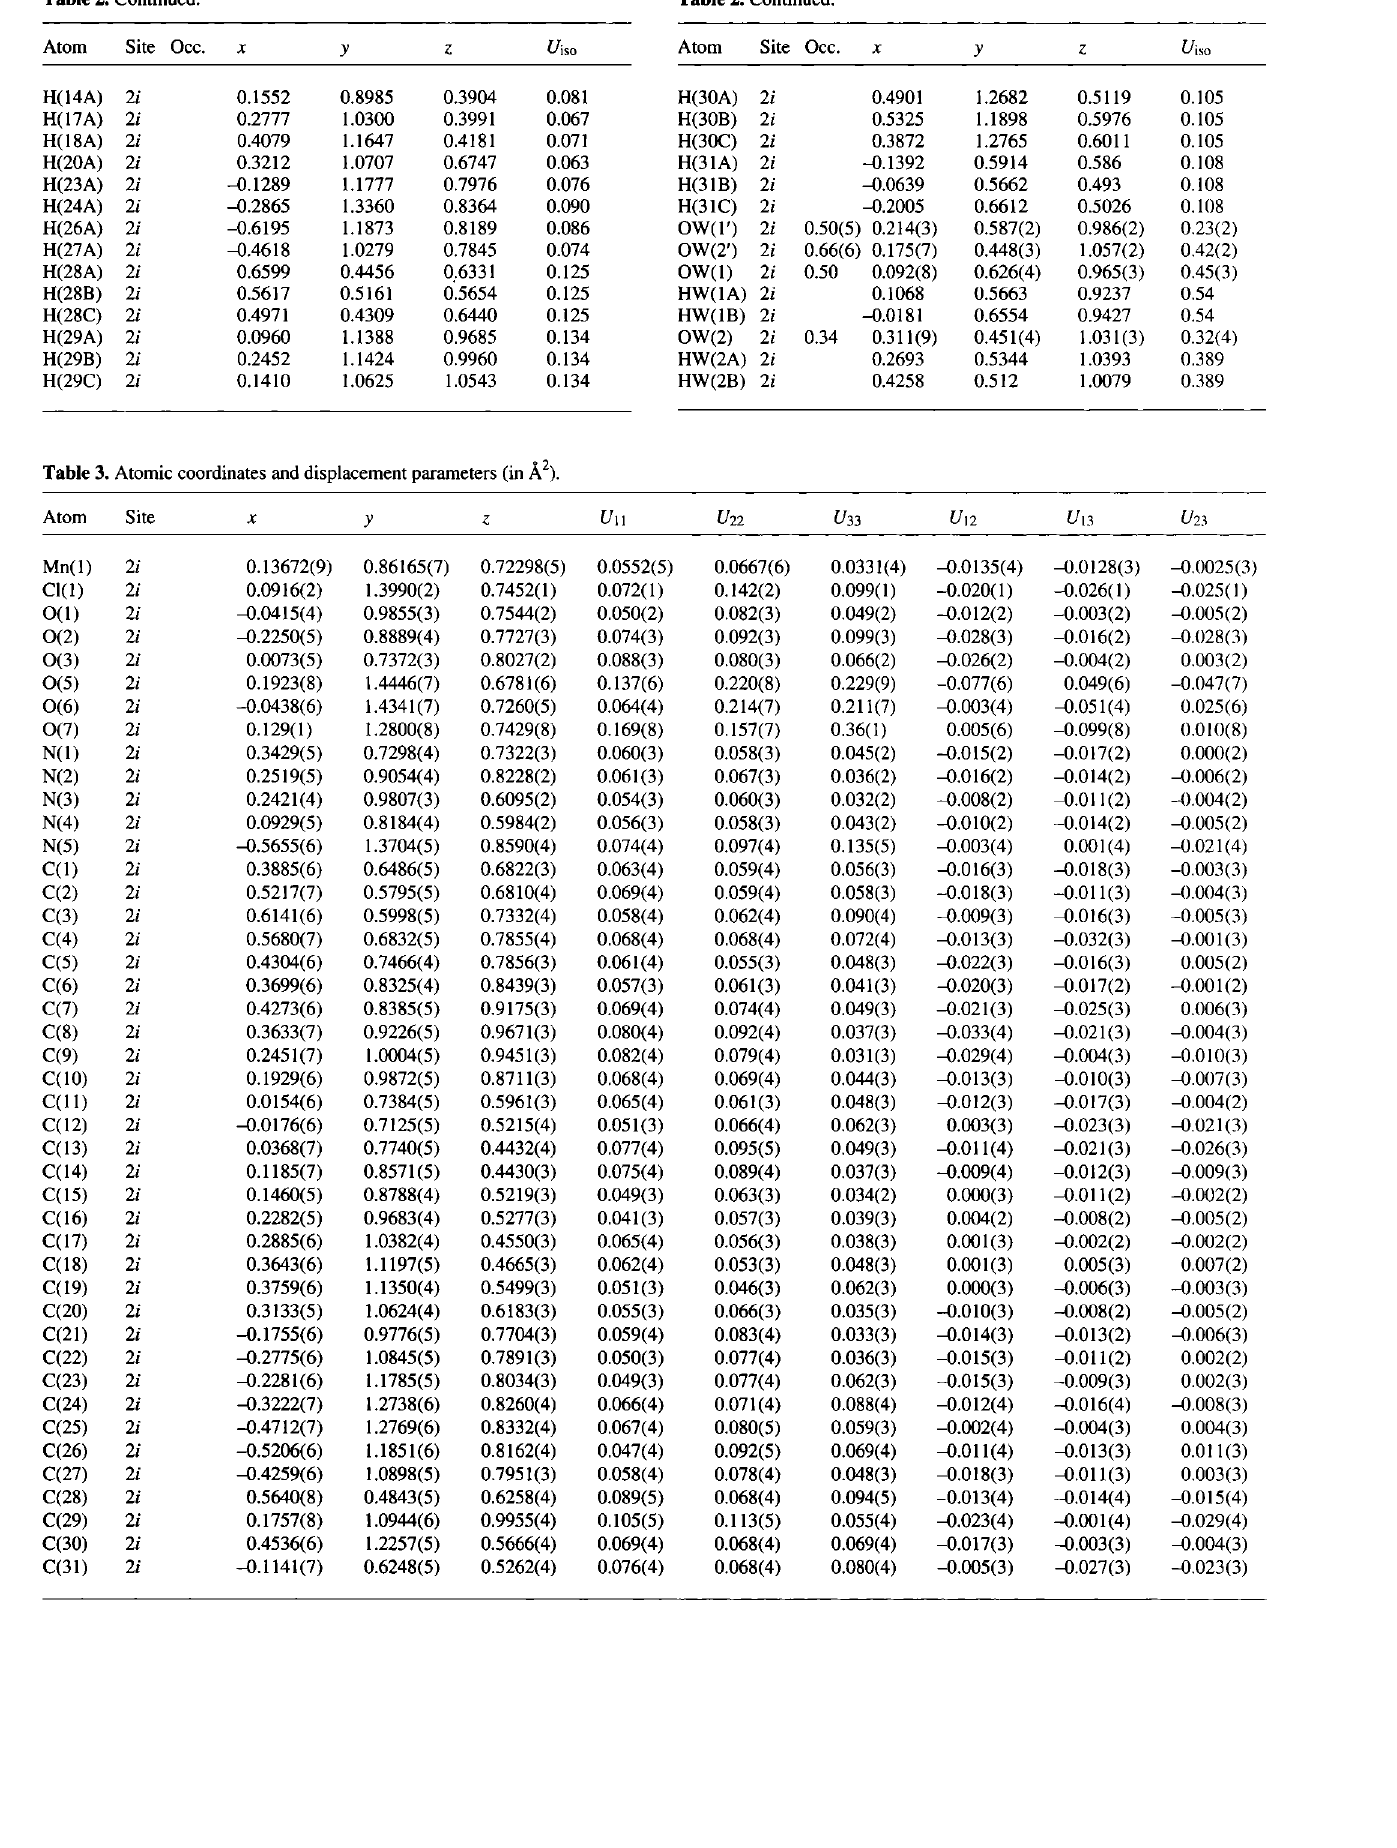
Table 3. Atomic coordinates and displacement parameters (in Ä 2